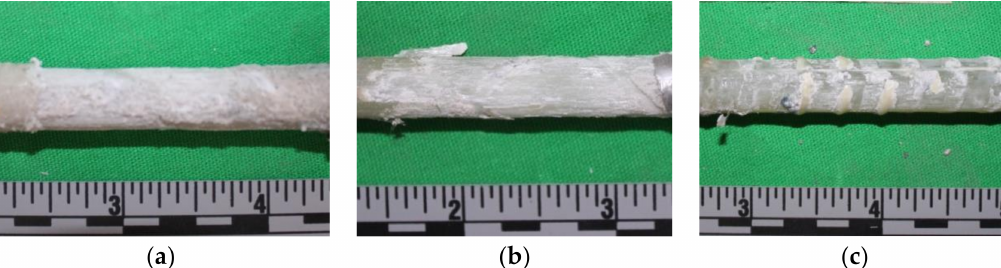
Figure 7. Bond surface of the GFRP rebar after completion of the bond test: type A ( a ), type B ( b ) and type ( c